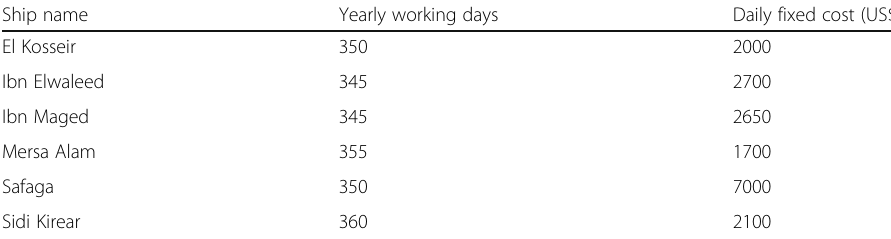
Table 10 Ship yearly working days and daily fixed cost in